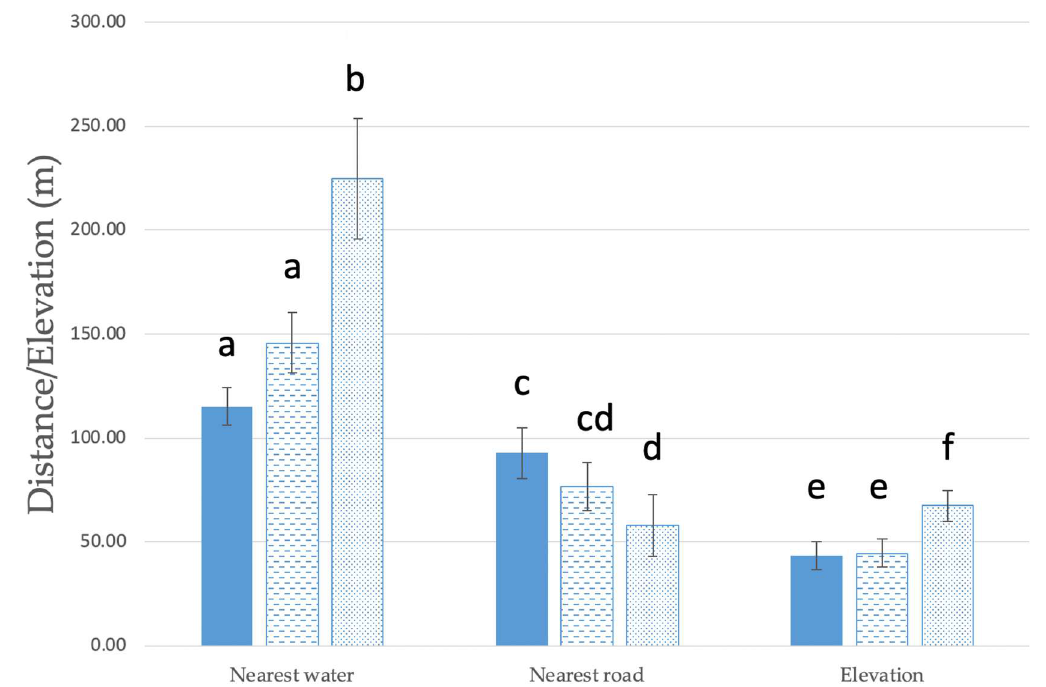
Figure 1. Mean proximal residential setting of typhoid cases versus control households in Central Division, Fiji (Cases; n = 80, Control I; n = 80, Control II; n = 80). Solid columns = Cases; dashed columns = Control I; dotted columns = Control II; error bars = +/ − standard error. Only significant parameters are shown. Within each set of columns, sequential lettering indicates significant di ff